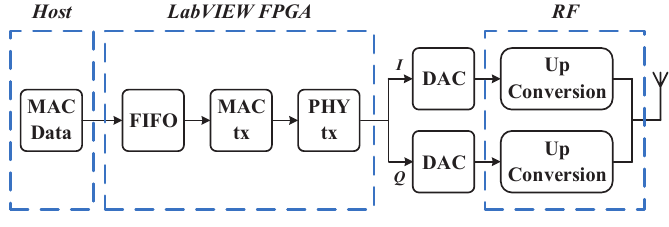
Figure 8. Functional diagram of the mobile